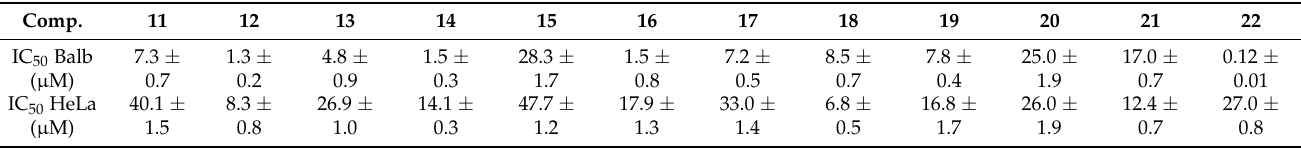
Table 3. IC 50 ( µ M) values of the series 1 of isatin derivatives in murine fibroblast 3T3 and human cervical cancer cells.